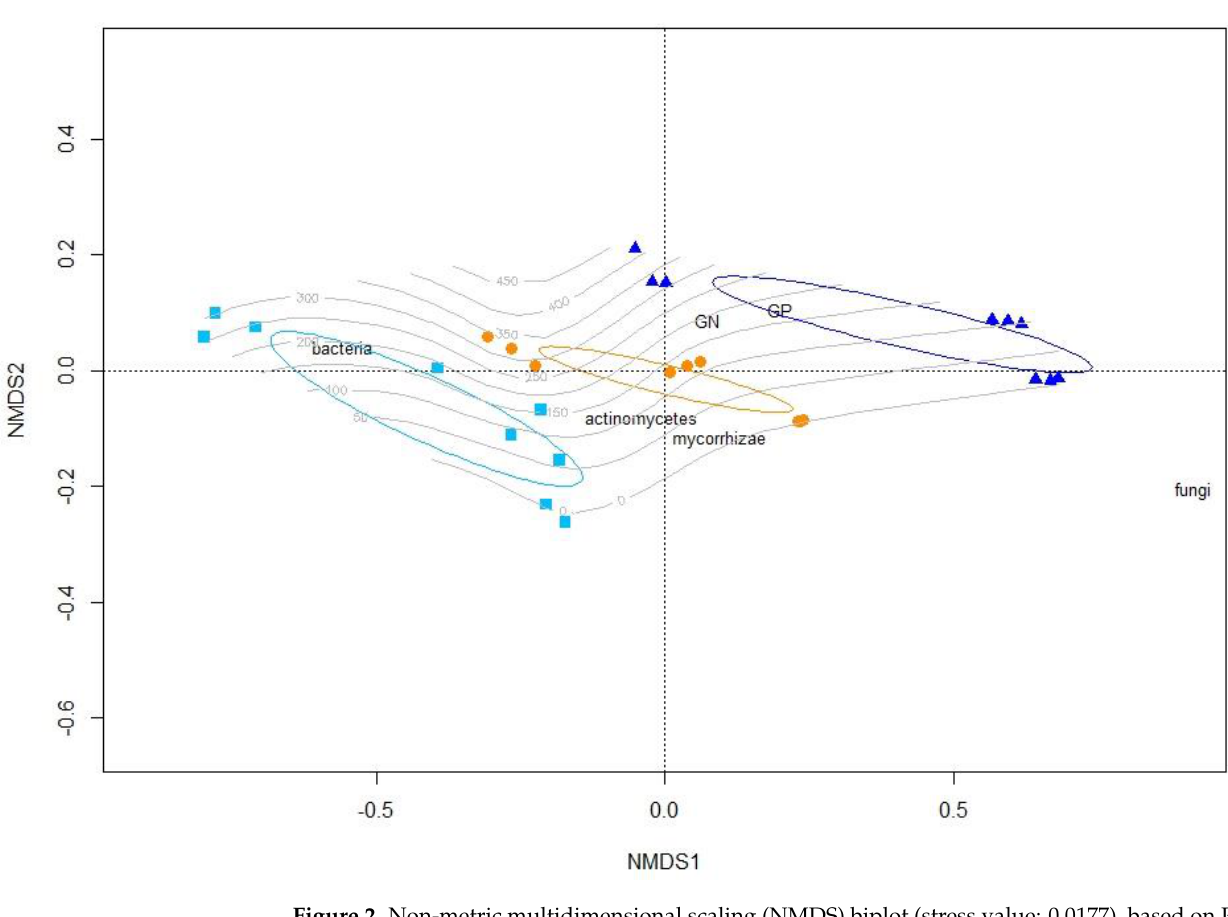
Figure 2. Non-metric multidimensional scaling (NMDS) biplot (stress value: 0.0177), based on PLFA groups, with the superimposition of the confidence ellipses (for α = 0.05) for the soil types (N1: yellow circles and line; N2: blue triangles and line) and industrial (I: light blue squares and line), as well as of the temporal gradient (grey lines).